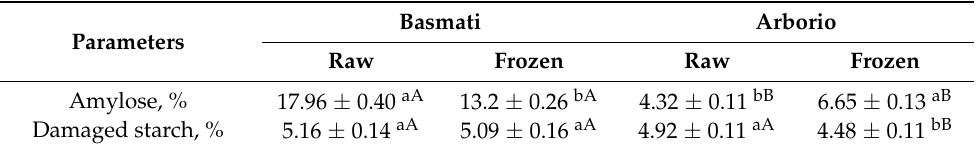
Table 4. Starch properties of flours obtained from raw and frozen Basmati and Arborio commercial rice